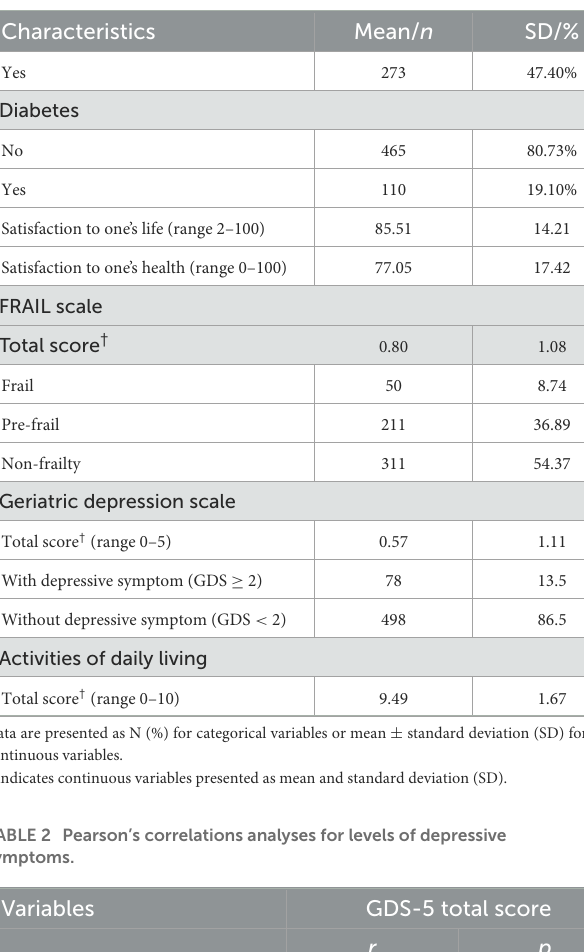
TABLE 3 T -test or one-way ANOVA of research